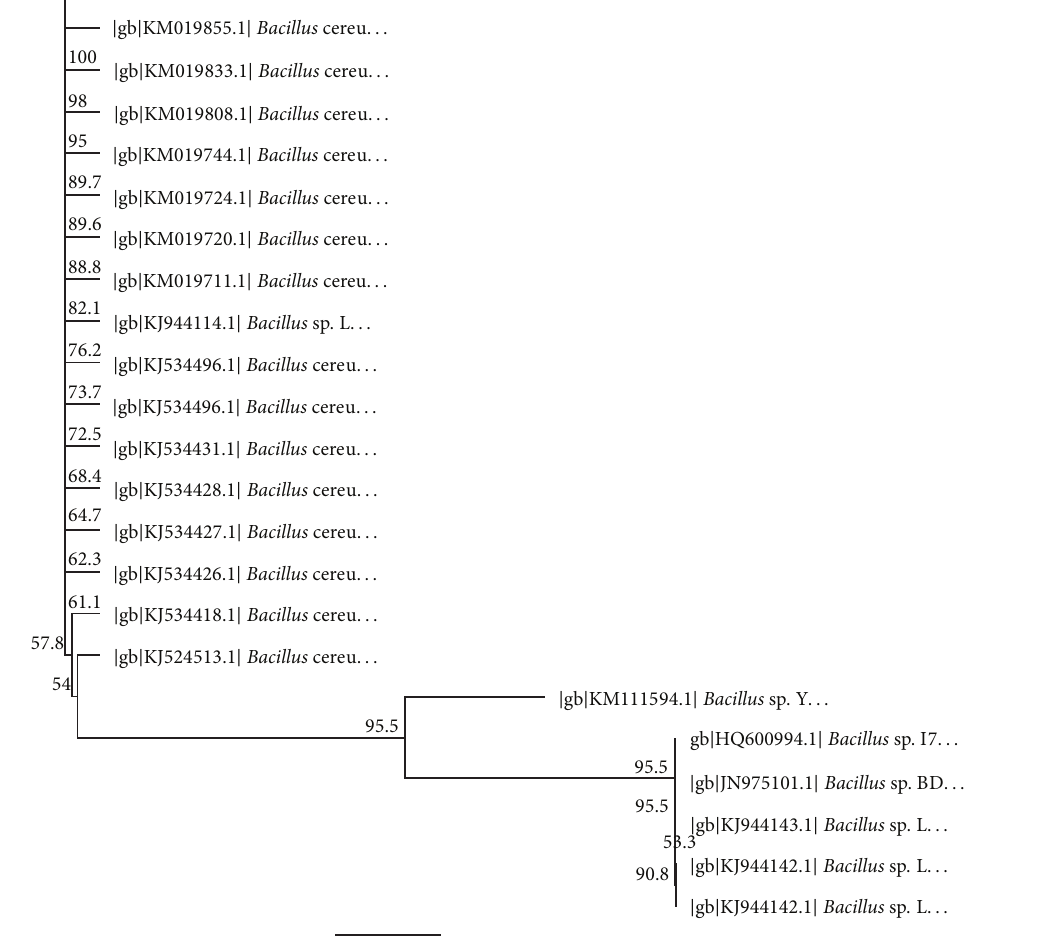
Figure 2: Neighbor-joining tree showing the phylogenetic relationship between 16S rDNA sequence of the candidate bacterial isolate S9 (taxonomically nominated as Bacillus sp. YAS 1 strain) and other 16S rDNA sequences belonging to closely related bacteria. Phylogenetic tree was constructed via Geneious R8 software. Numbers on branch nodes represent bootstrap values (1000